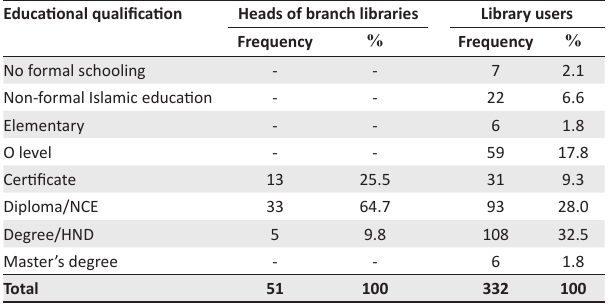
TABLE 3: Distribution of the participants by their highest educational qualifications. Educational qualification